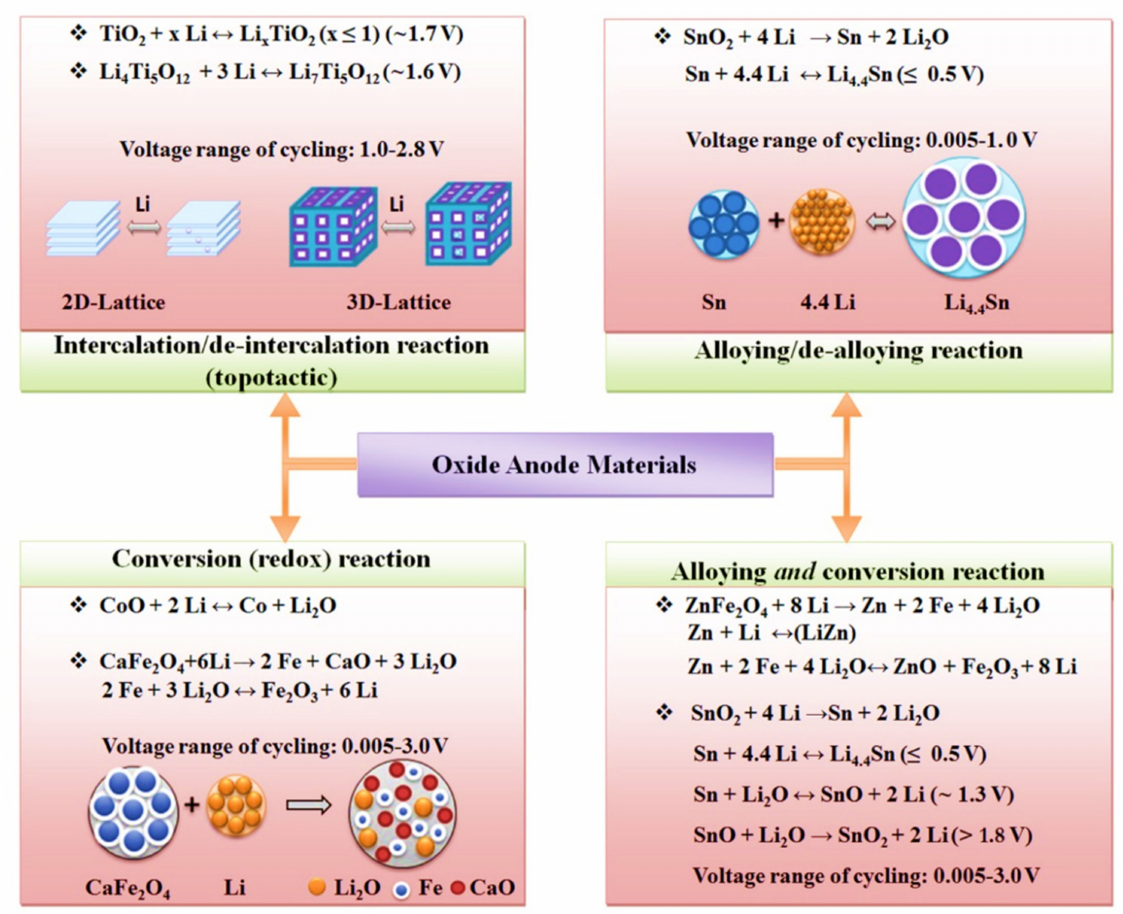
Figure 8. Reaction mechanisms of anode materials for Lithium batteries (adapted with permission from [133]. Chem Reviews, 2013).